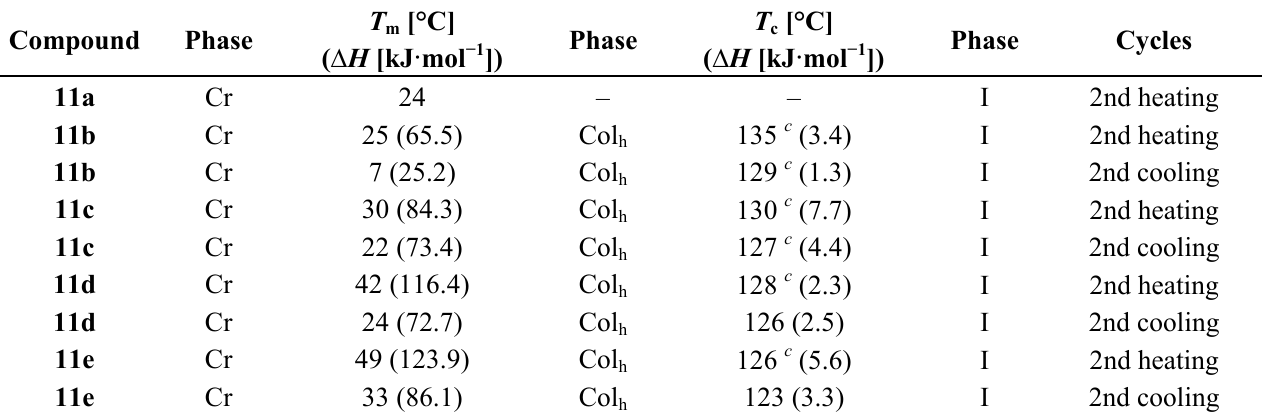
Table 1. Phase transitions of the mesogenic boroxines 11a – e . a , b